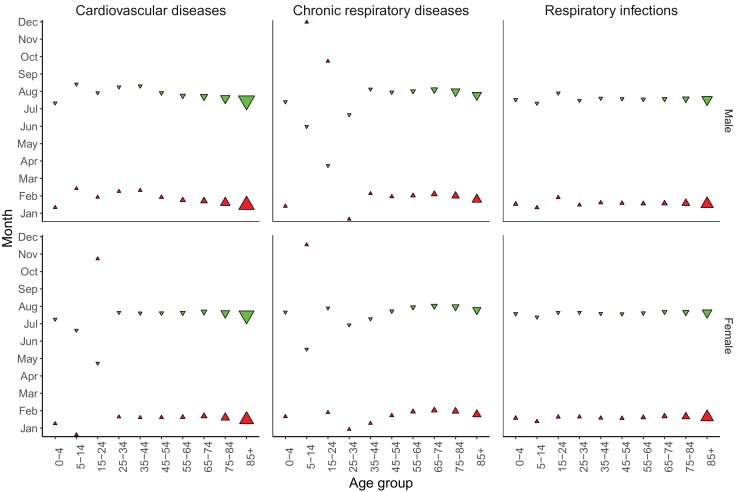
Mean timing of maximum and minimum mortality for specific cardiorespiratory diseases at the national level, by sex and age group for 1980–2016.Red arrows indicate the month of maximum mortality, and green arrows that of minimum mortality. The size of the arrow is inversely proportional to its respective variance.